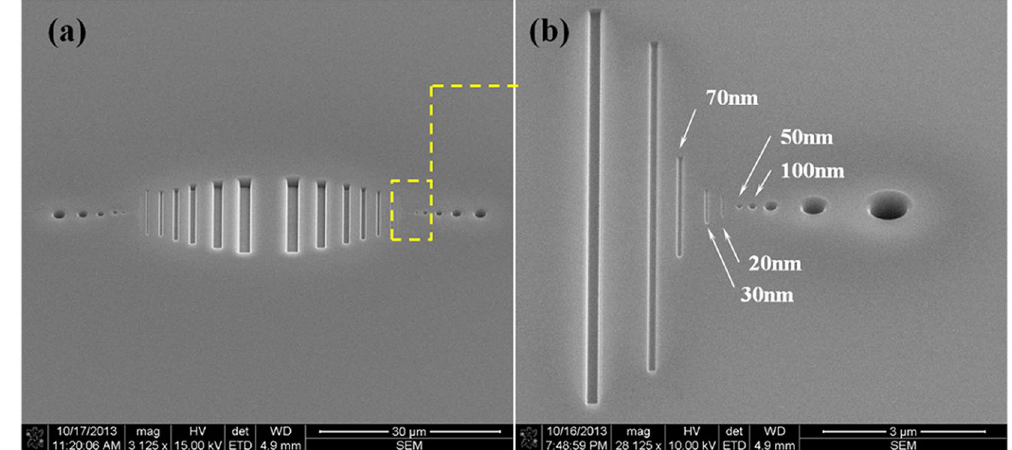
Figure 1. The embossing die. ( a ) The gratings and pores on the die. ( b ) The nanometer gratings and pores on the